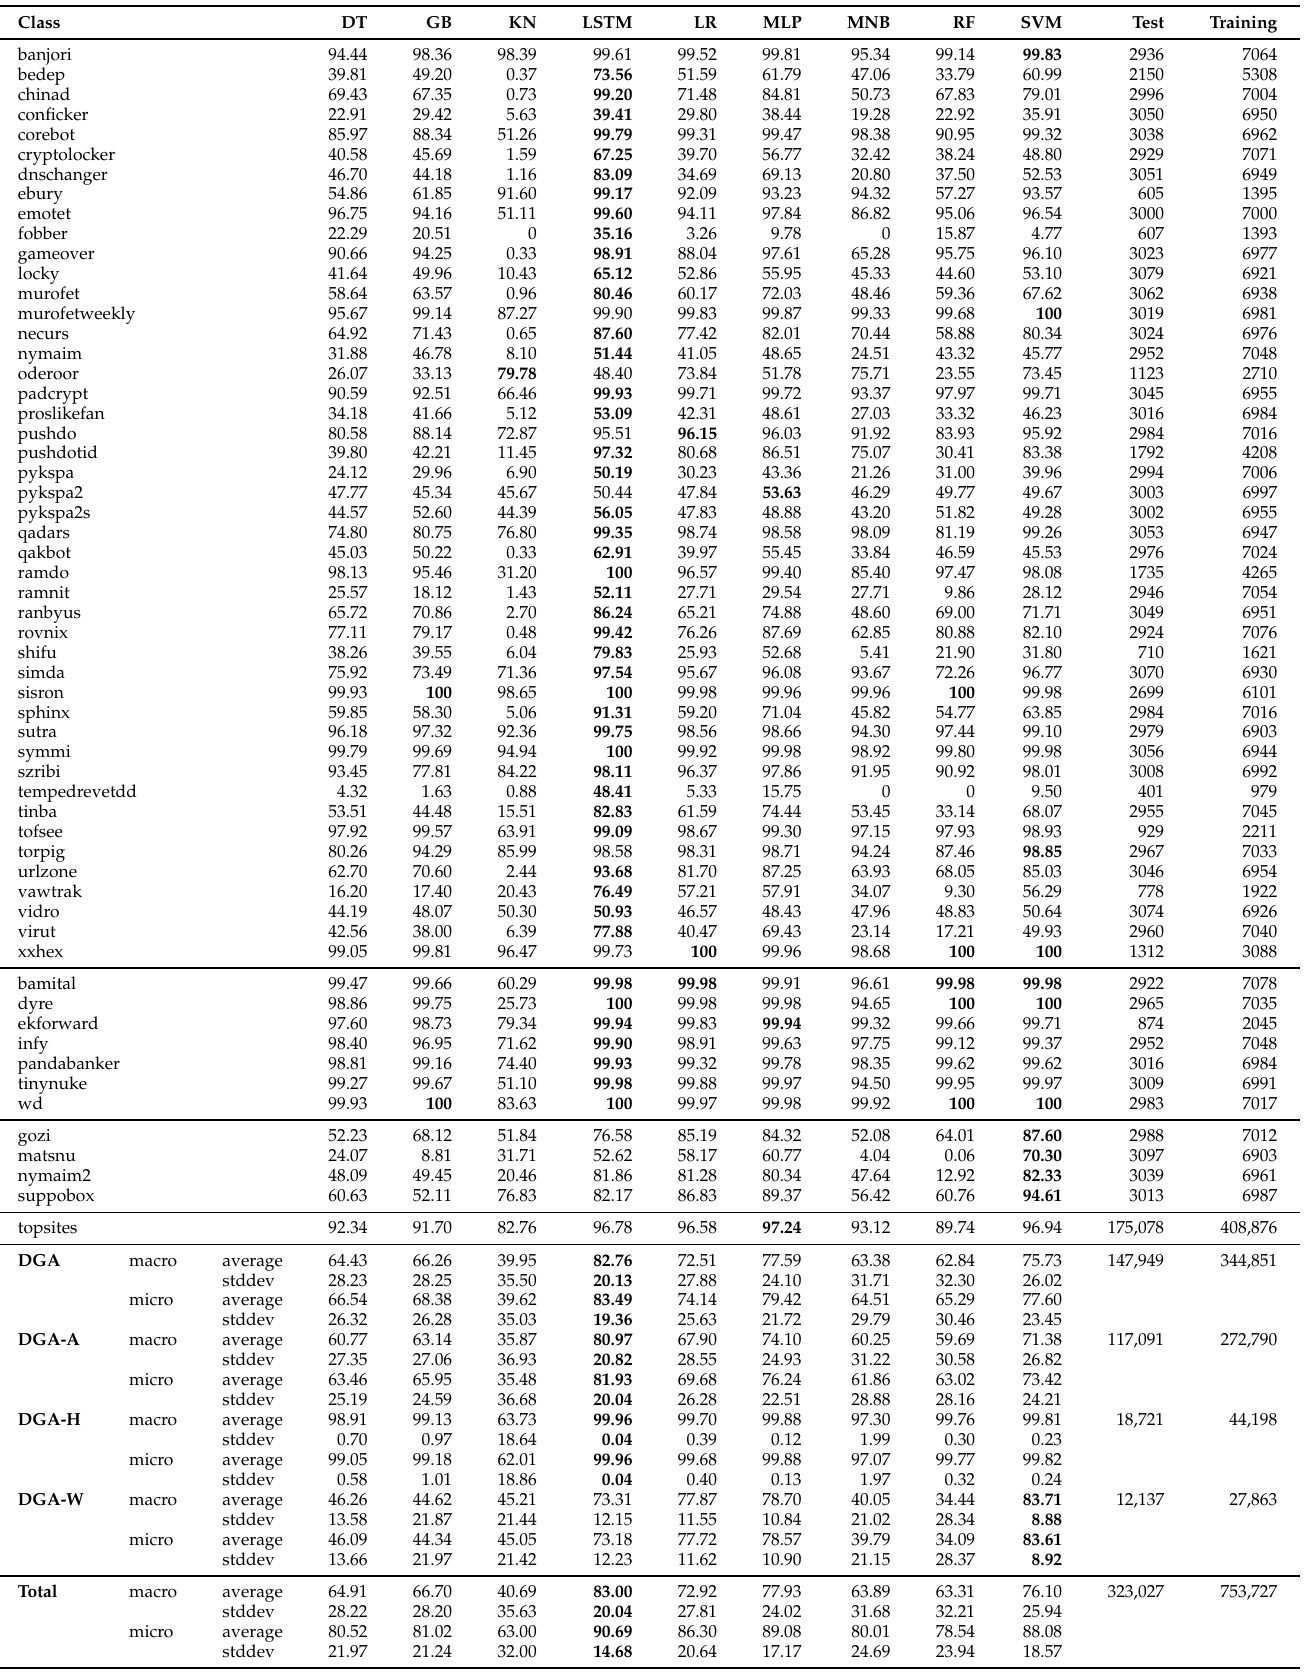
Table 9. F1-score (expressed as